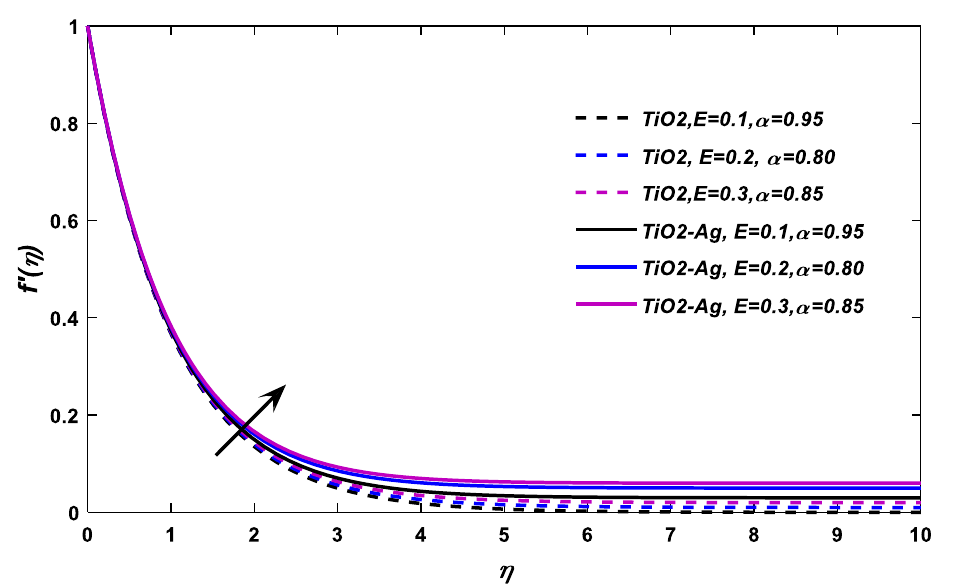
Figure 7. E versus velocity field when M = 0.1, (cid:31) = 0.05, φ 1 , φ 2 = 0.02, Pr =